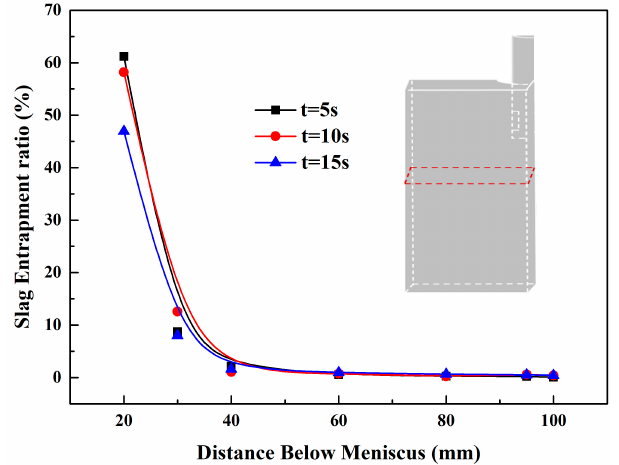
Figure 9. Slag entrapment ratio in each cross section.